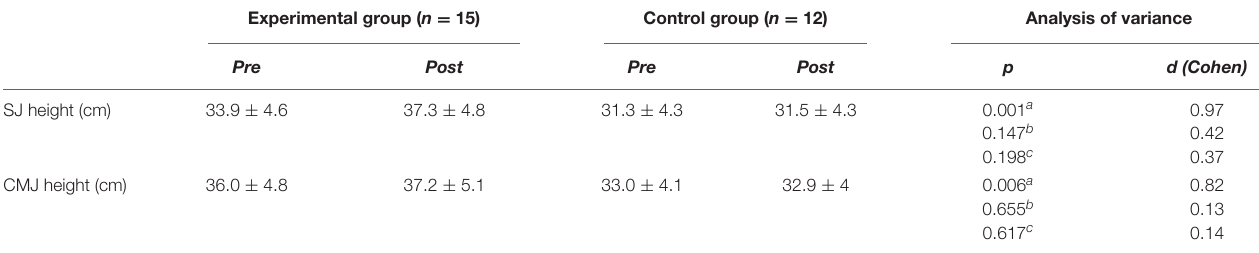
TABLE 7 | Comparison of squat jump and counter movement jumps between experimental and control groups before (pre) and after (post) the 8-week trial. Experimental group ( n = 15) Control group ( n = 12) Analysis of variance Pre Post